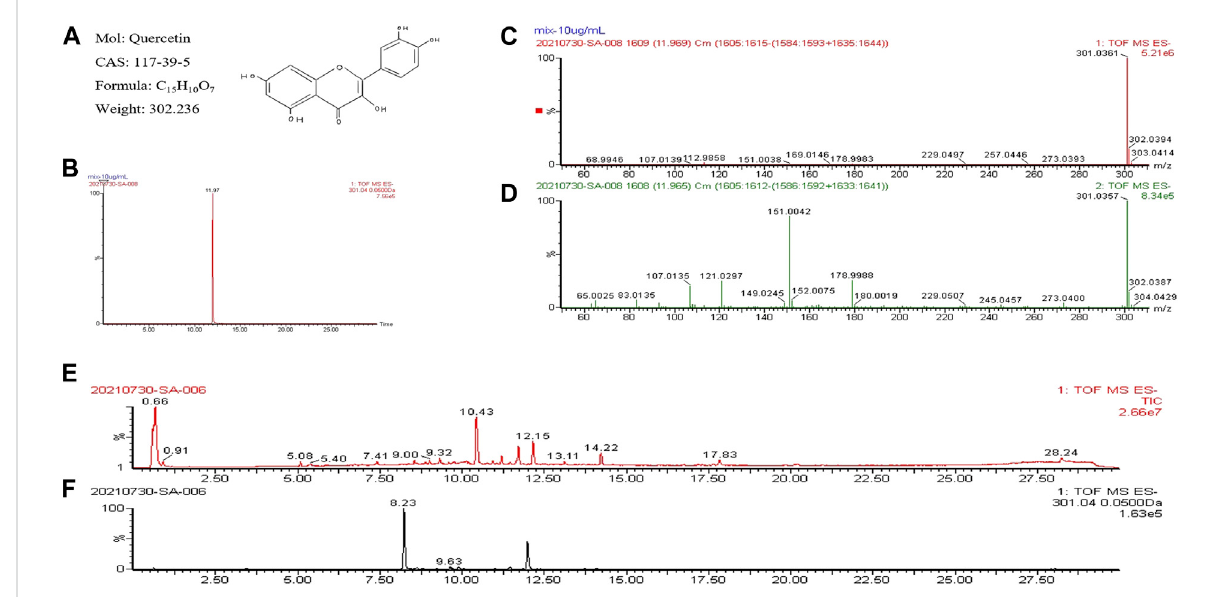
FIGURE 4 UPLC-Q/TOF-MS analysis of quercetin and BYLY. (A) Chemical properties of quercetin. (B) Chromatogram of quercetin. (C) Low-energy spectrum of quercetin. (D) High-energy spectrum of quercetin. (E) Total ion chromatogram of BYLY. (F) Chromatogram at m/z 301.04 of BYLY. Abbreviation: BYLY, Bushen Yiqi Lixue Yangtai